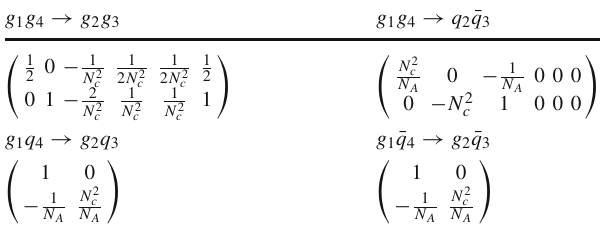
Table 4 Matrices M of structures appearing in four-parton processes. The subscripts in the sub-process indication correspond to the momenta enumeration g 1 g 4 → g 2 g